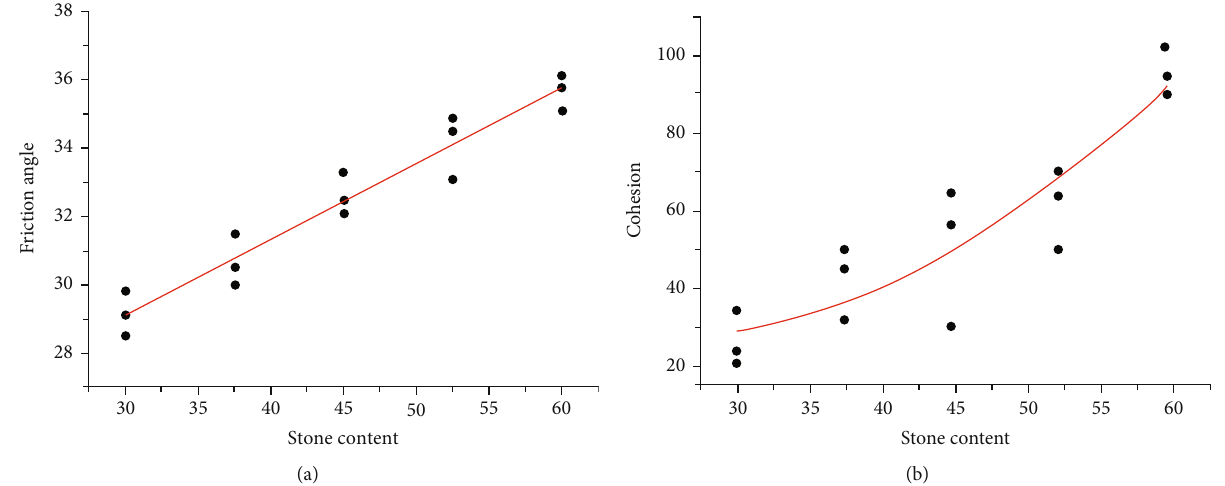
Figure 13: Relationship between shear strength parameters and stone content of gravel soil mixture: (a) relationship between friction angle and stone content; (b) relationship between cohesion and friction